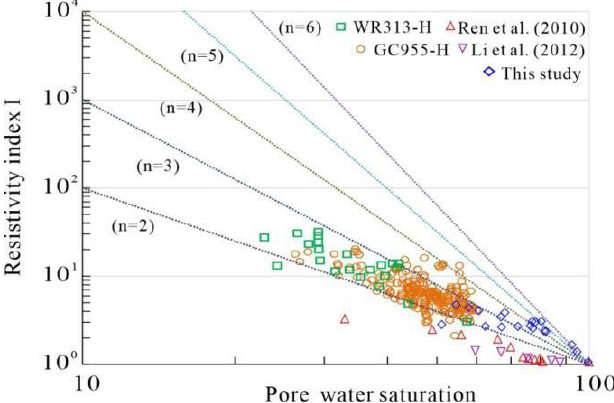
Figure 11. Comparison of the resistivity index from the fitting model and the results of previous research [17].